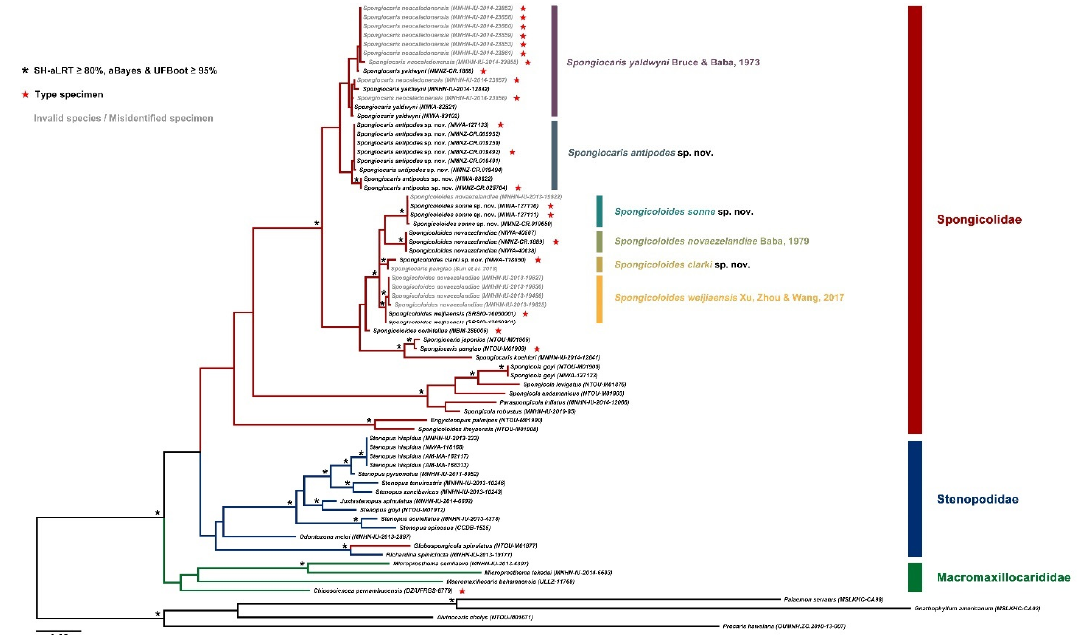
Figure 2. Maximum likelihood tree inferred from the 16S rRNA gene sequences. The colors of the branches indicate the familial affiliation proposed by Bochini et al. [10] . * indicate high nodal support and a star highlights a type specimen.